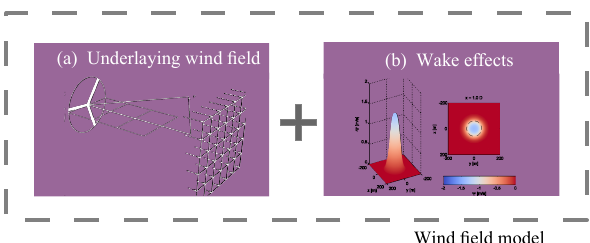
Figure 3. The general concept of model-based wind field recon- struction, in which the wind field characteristics are estimated by fitting simulated lidar measurement data ( v los , s ) to measurements ( v los , m ).